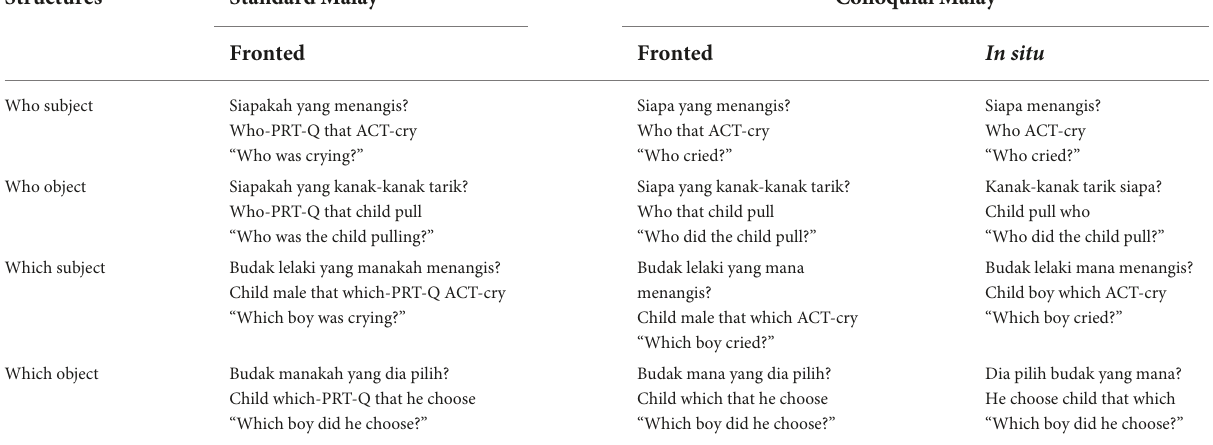
TABLE 1 Examples of Wh- interrogative sentences for standard Malay and colloquial Malay.